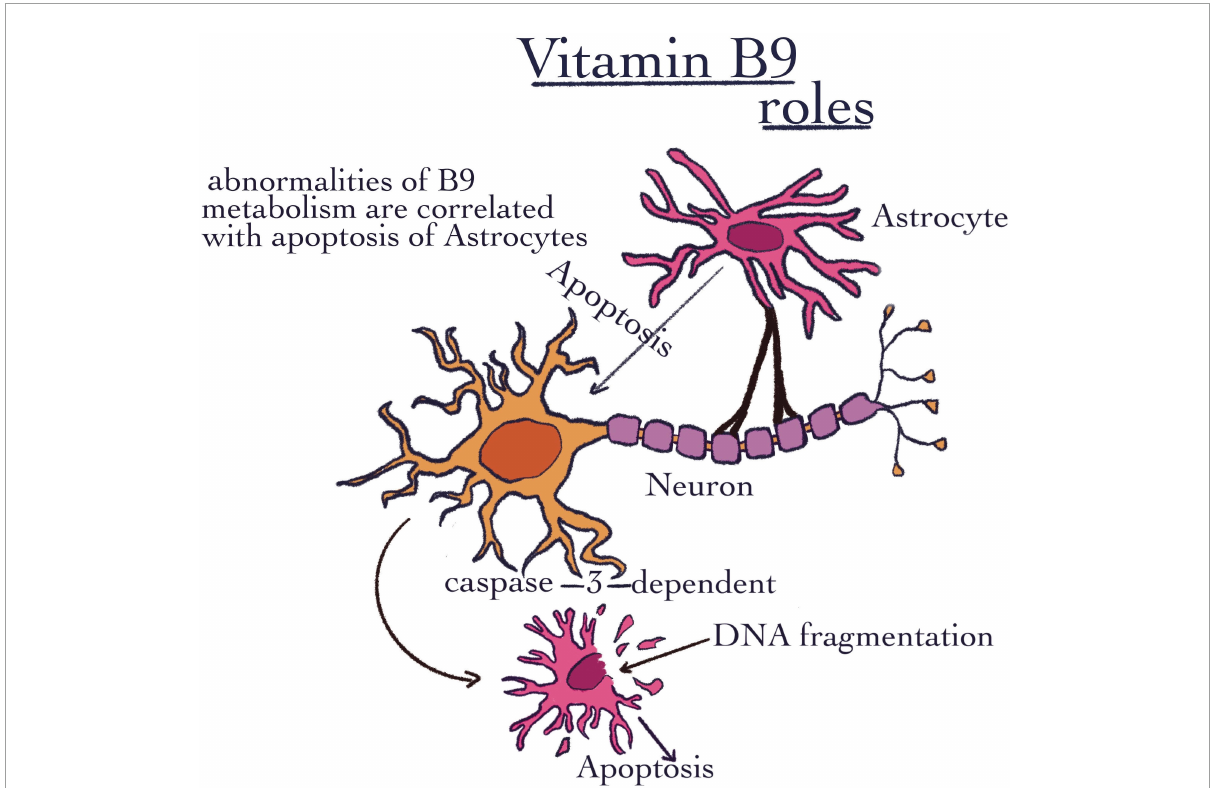
FIGURE5 Vitamin B9 roles. The image shows the importance of VB9, which was highlighted through abnormalities of B9 metabolism that are correlated with the apoptosis of